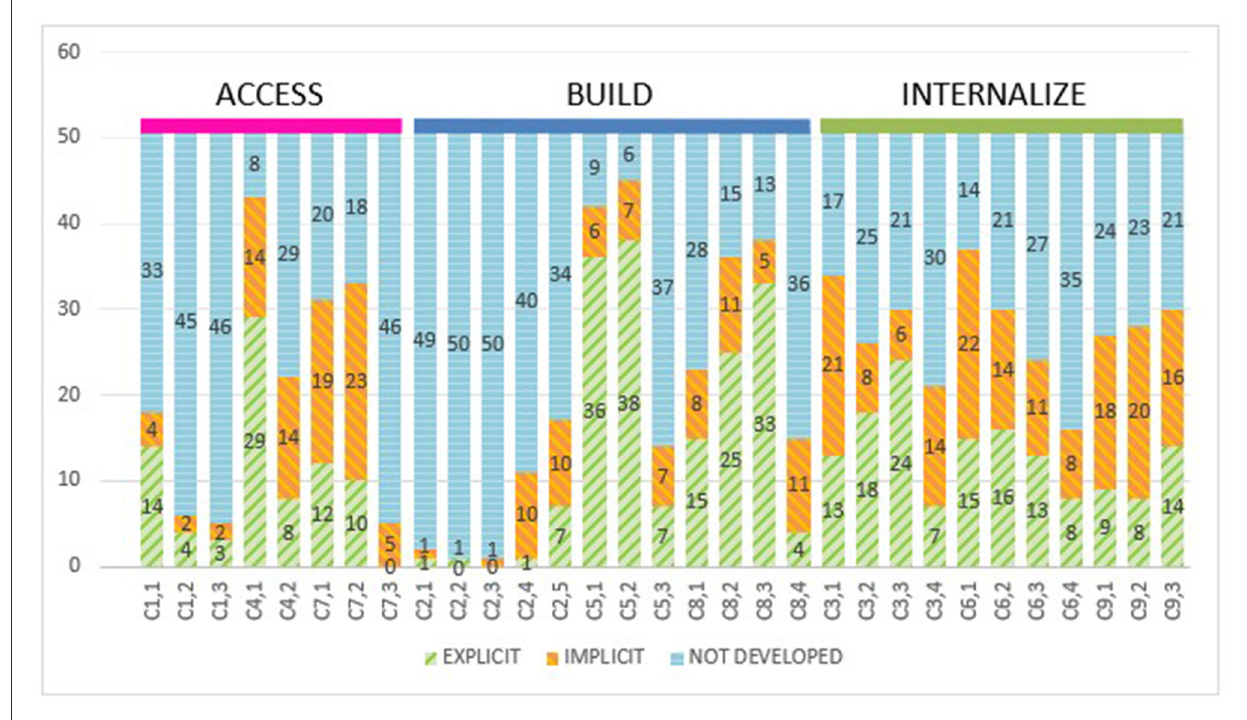
FIGURE4 Explicit, implicit, and not developed uses sorted by access , build, and internalize categories.